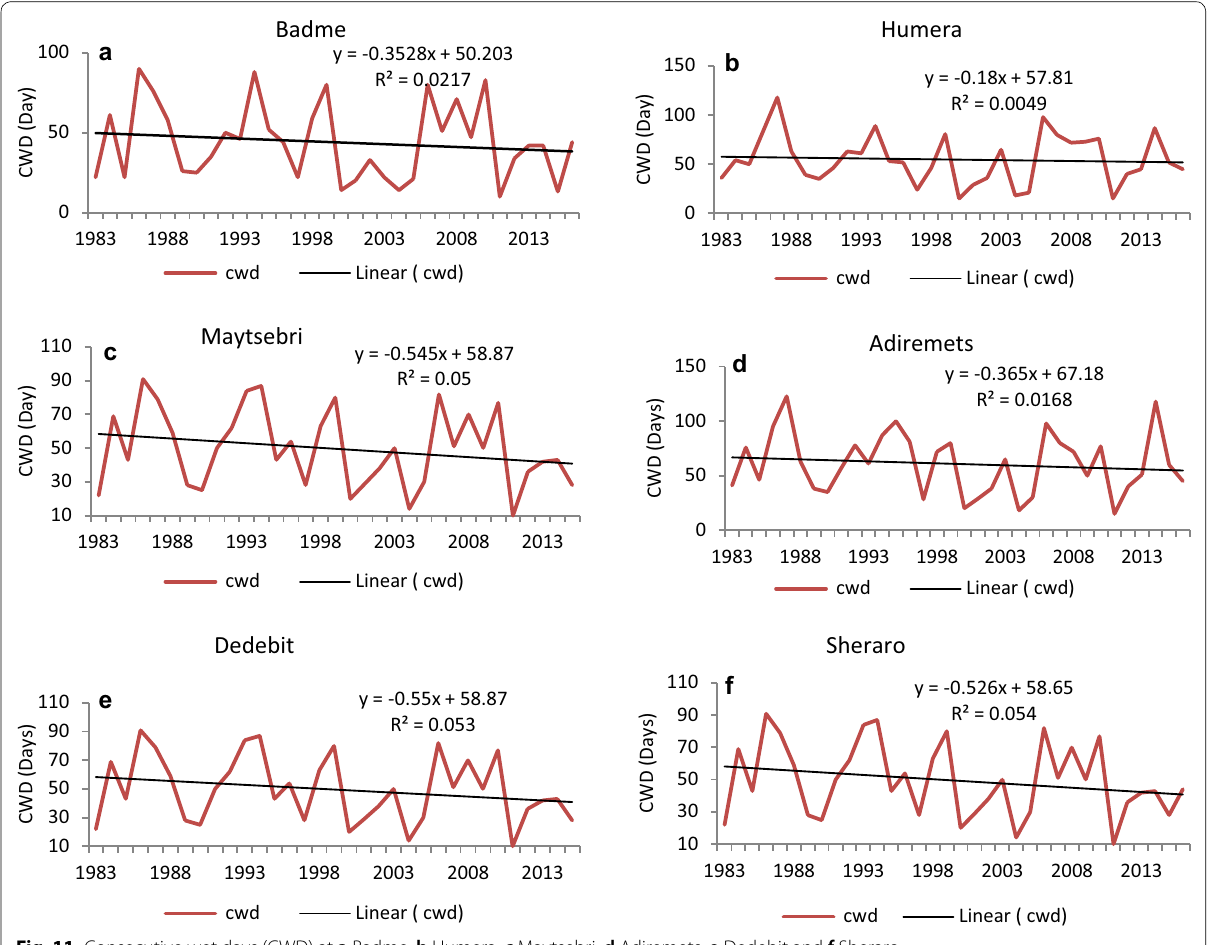
Fig. 11 Consecutive wet days (CWD) at a Badme, b Humera, c Maytsebri, d Adiremets, e Dedebit and f